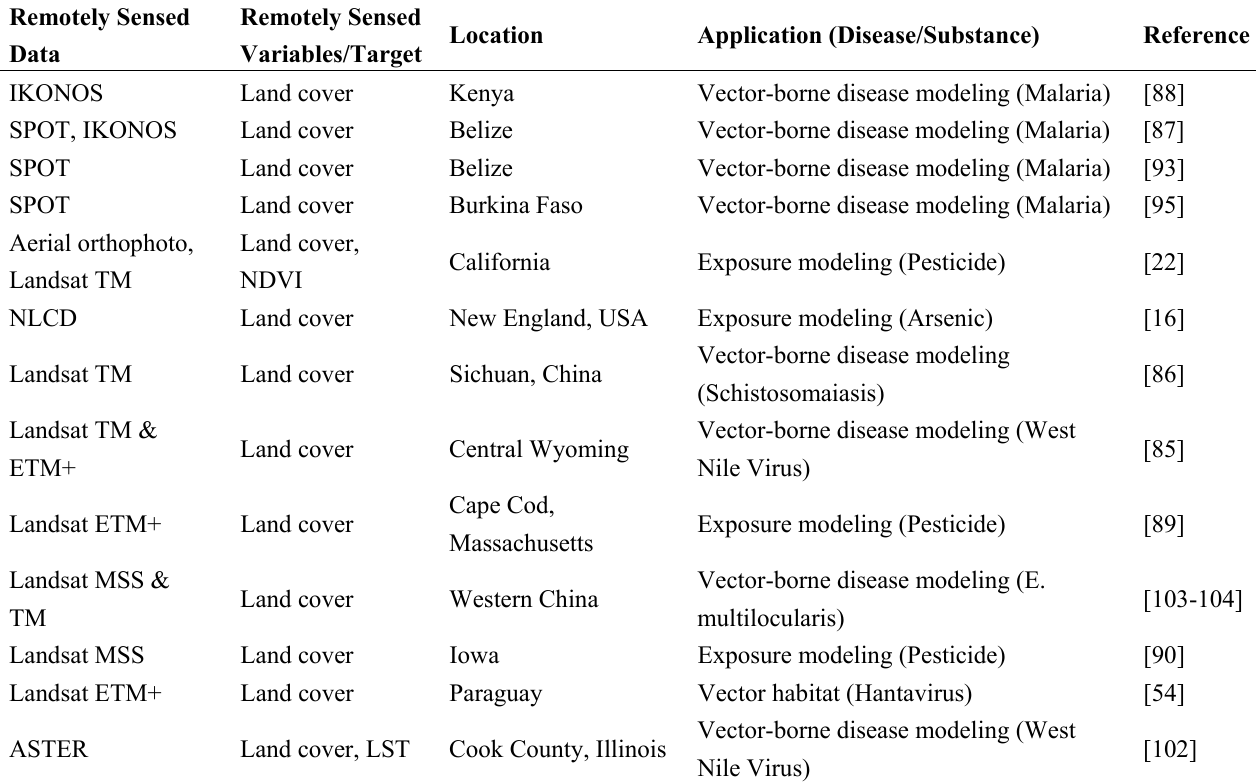
Table 2. Summary of literature in public health using discrete data